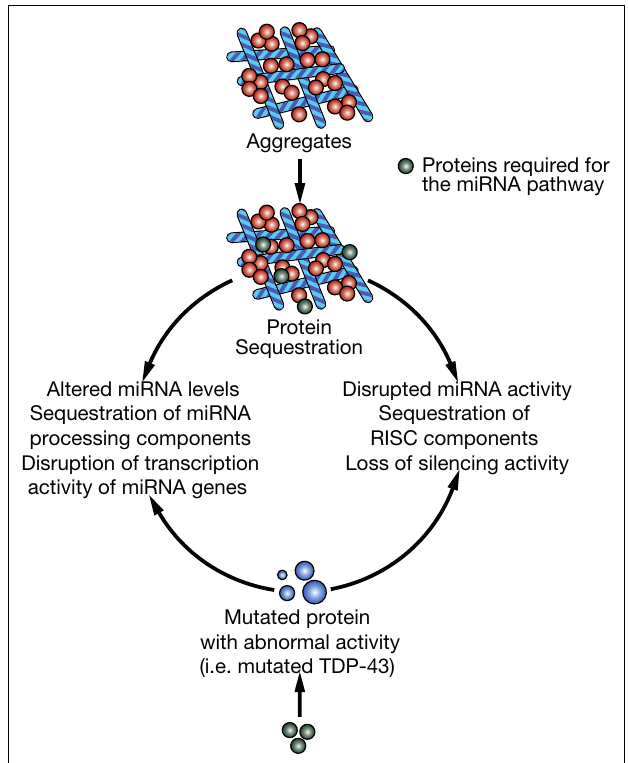
FIGURE 3 | Potential mechanisms of miRNA deregulation downstream of protein aggregation/dysfunction. Two basic mechanisms could affect miRNA regulatory networks: (1) alteration of miRNA levels through deregulation of transcription (i.e., miR-9 downstream of HTT and REST) or processing (i.e.,TDP-43 altering Drosha function) and (2) interference with RISC activity (i.e., ataxin-2 seems to be required for optimal miRNA